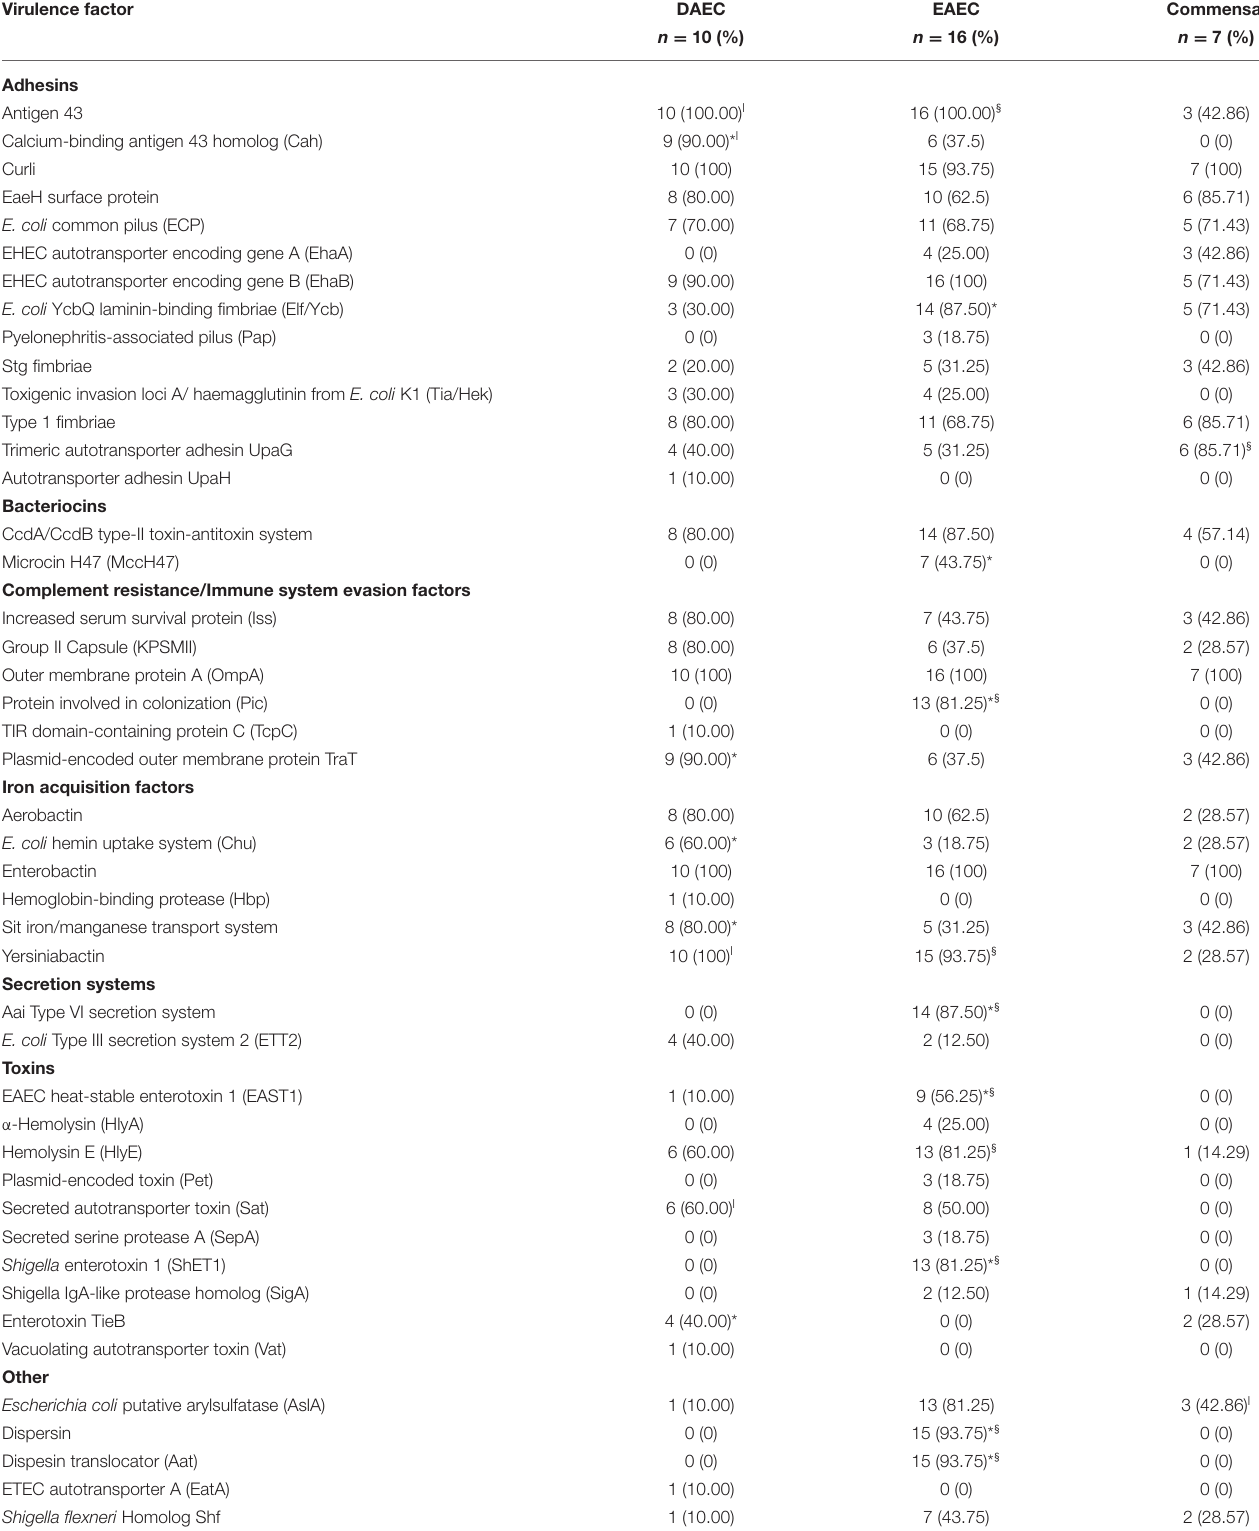
TABLE 3 | Virulence factors encoded in DAEC, tEAEC, and commensal E. coli